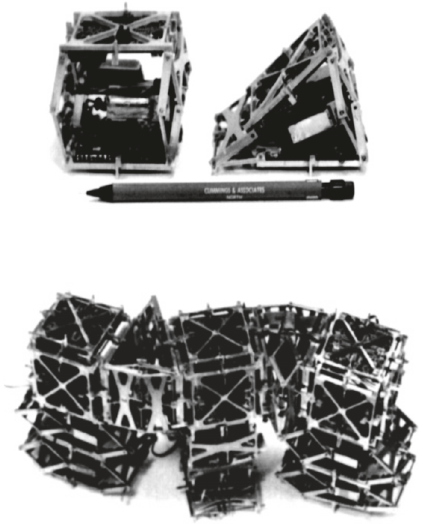
Figure 8: Polypod MSRR (source: http://robotics.stanford.edu/ users/mark/photos.html).